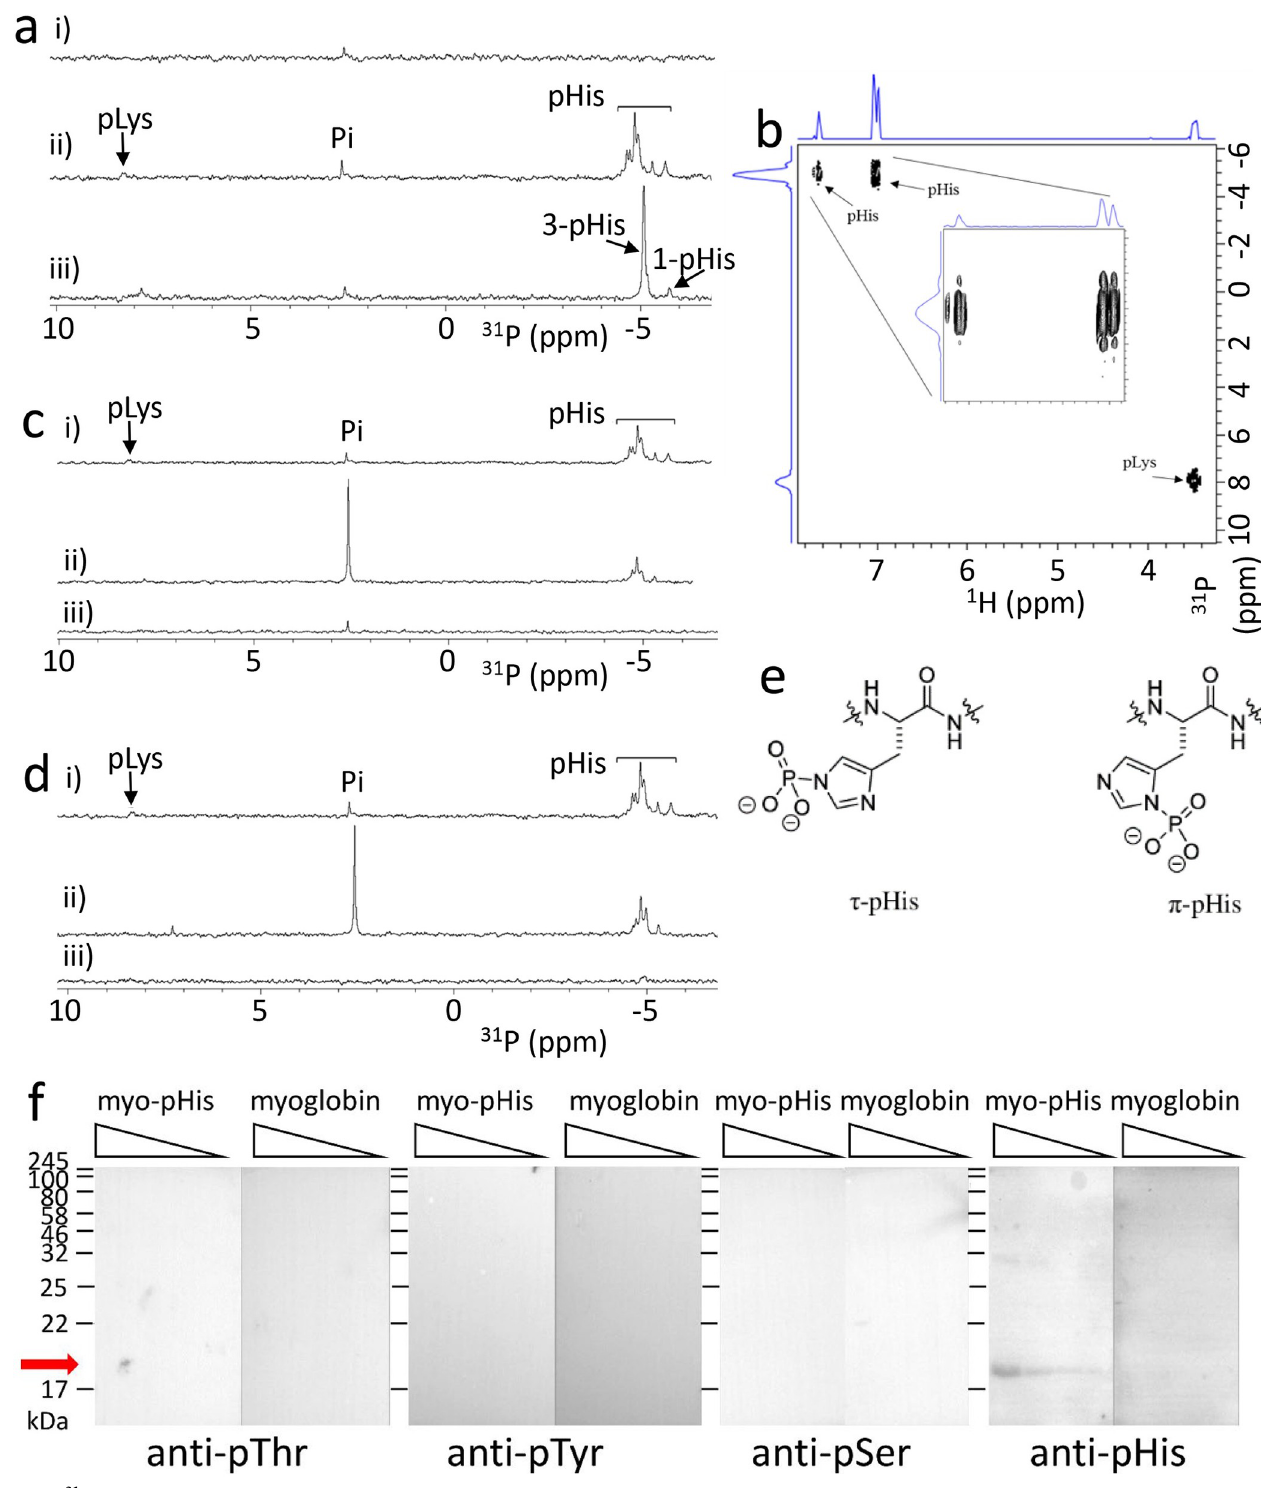
Fig 1. 31 P NMR spectra of Myo-pHis. a) Phosphorylation of histidines in myoglobin i) Native myoglobin, pH 10.8; ii) Myo-pHis, pH 10.8, following phosphorylation with potassium phosphoramidate, buffer exchange to pH 10.8, and concentration (18.2 mg/mL); iii) Denatured myo-pHis. The Myo-pHis sample used was the same sample as Fig 1aii. The signals from 3-pHis and 1-pHis are indicated. This distinction is not possible in the native protein because of the spread of chemical shifts due to the folded structure. b) HMBC NMR spectrum of Myo-pHis, sample from Fig 1aiii. The expansion inset shows the slightly